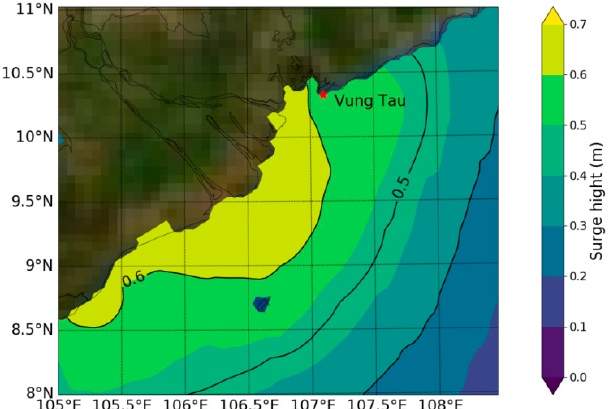
Figure 11. Wind and pressure re-analyzed on ( a ) 27 October 2010 and ( b ) 29 October 2010.